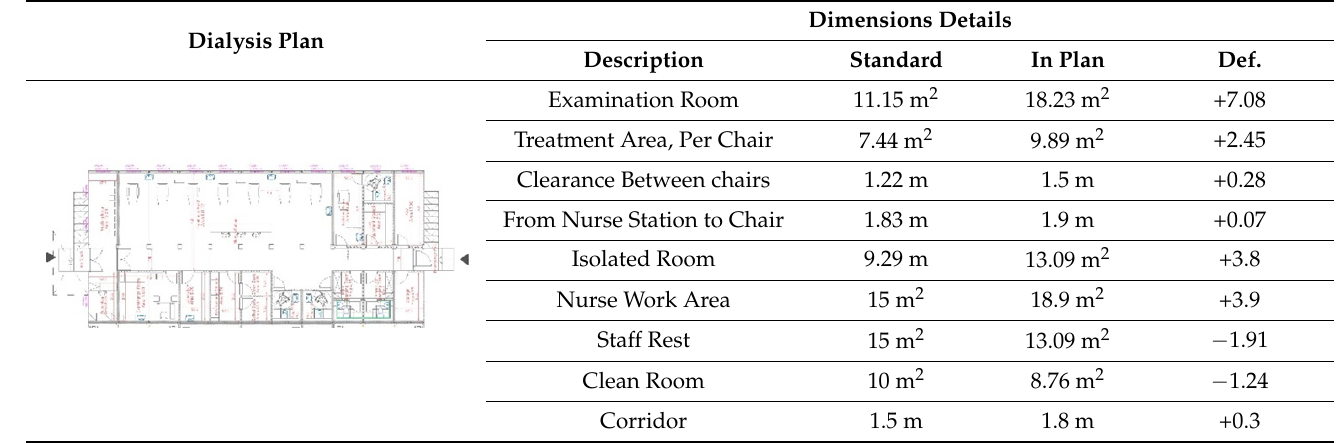
Table 3. Dimensional requirements of the dialysis department compared to standards.